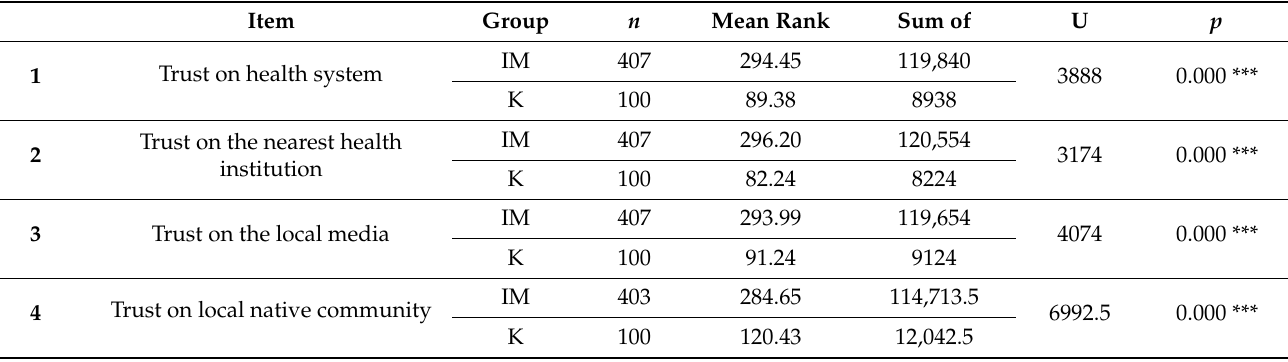
Table 4. Mann–Whitney U-Test on Trust